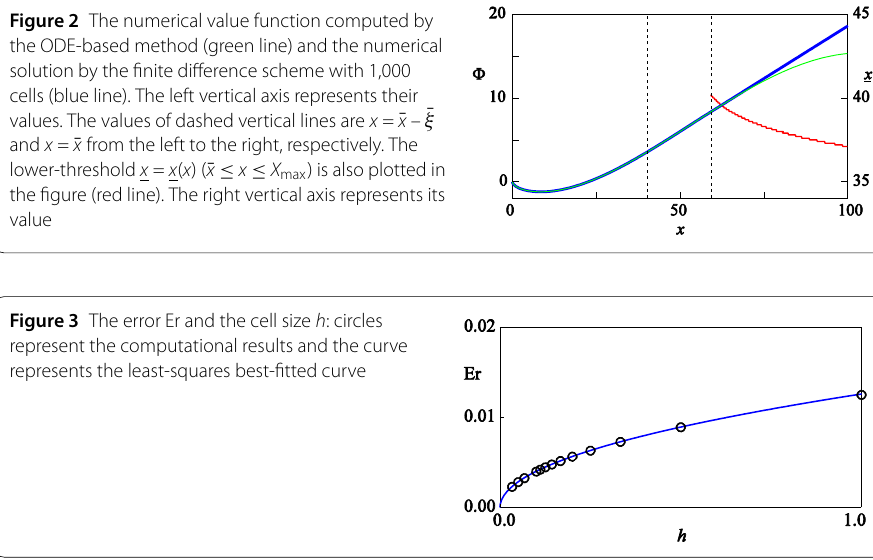
Figure 2 The numerical value function computed by the ODE-based method (green line) and the numerical solution by the finite difference scheme with 1,000 cells (blue line). The left vertical axis represents their values. The values of dashed vertical lines are x = ¯ x – ¯ ξ and x = ¯ x from the left to the right, respectively. The lower-threshold x = x ( x ) ( ¯ x ≤ x ≤ X max ) is also plotted in the figure (red line). The right vertical axis represents its value